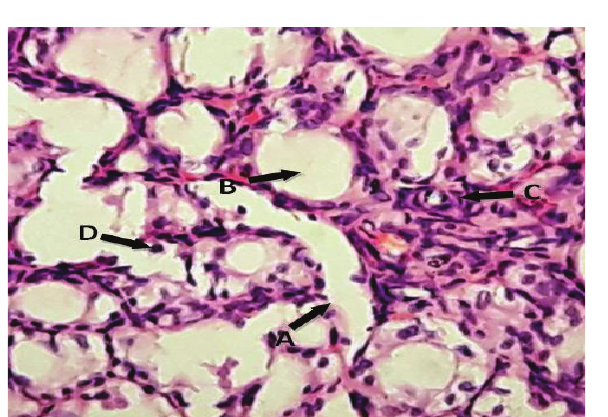
Figure 2: After receiving Methimazole 60mg/kg/day for